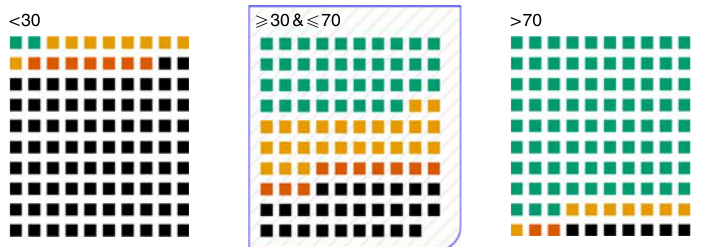
non-tolerable (0 to 7/20) or not completed, orange for failed but with a potentially tolerable score (8 or 9/20), green for passed with moderate score (10 to13/20), and bright green for passed with high score (14 to 20/20). For the global process tab, the first visualization (see Figure 3) uses gray dots for current year ’ s students, combined into three groups (depending on the study program, e.g. 0-30, 30-70, and 70-100 percent for engineering science). The second visualization (see Figure 4) uses colored squares to represent percentage units of previous year ’ s students (rather than dots for single students). Here, colors correspond to the time these students required to obtain the bachelor degree: black for students that dropped out, red for those who needed five years or more, orange for students with one year of delay (four years), and green for students that obtained the degree within the default three years. For each of the visualizations, the interpretation of colors and markers (dot or square) is explained using inline elements within the text.